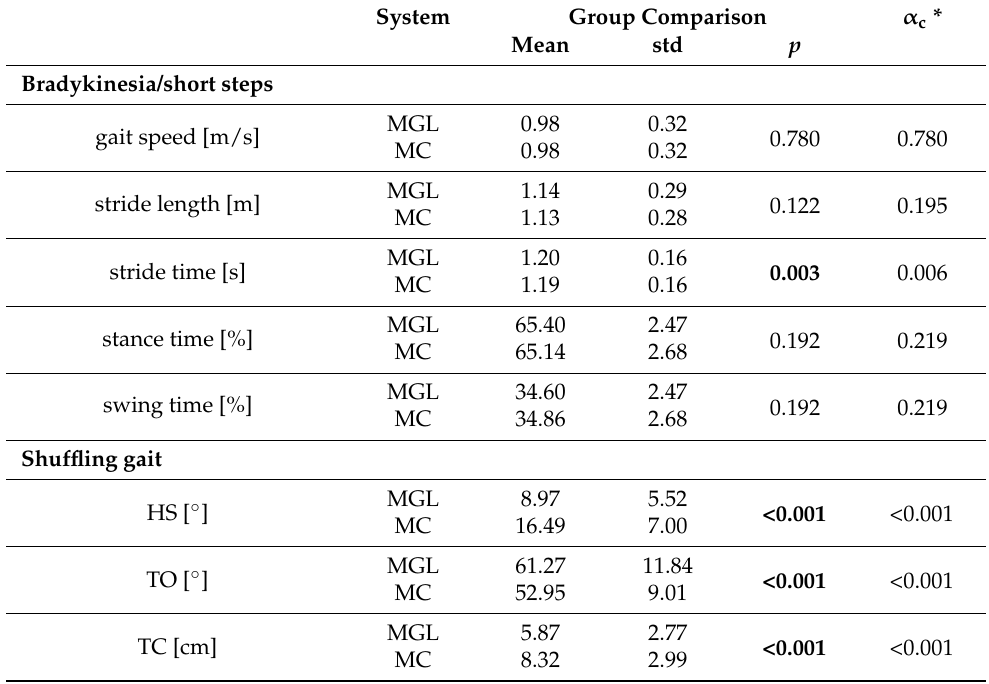
Table 3. Gait parameters recorded with MGL and MC (mean, standard deviation (std) and signifi- cance level ( p